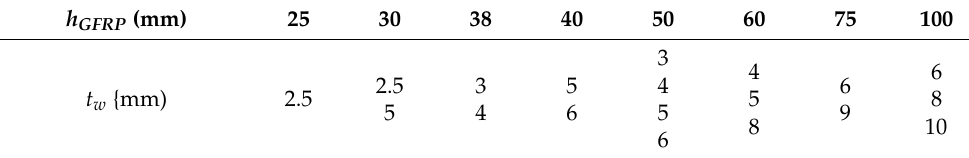
Table 1. Geometries of the available pultruded GFRP SHS stiffeners.